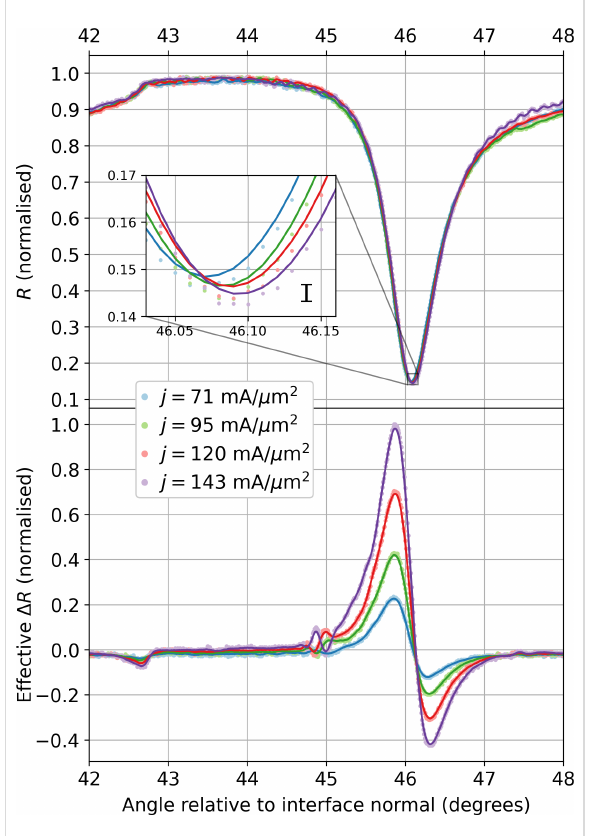
Figure 8: Plots of the enhanced SPR curves showing the typical SPR curve shapes (top) for a sapphire–silver–air configuration excited at 561 nm and the effective change in reflectivity (bottom) for a 20 μ m square active element modulated with an applied (RMS) current densi- ty of 71–143 mA/ μ m 2 in steps of ≈ 24 mA/ μ m 2 . The lock-in signal error is estimated at 0.5%. The inset emphasises the shift in the plasmonic resonance position for increasing temperatures with the error of the SPR signals included in black. The current densities were applied in ascending order. The solid lines are a centred moving average for each